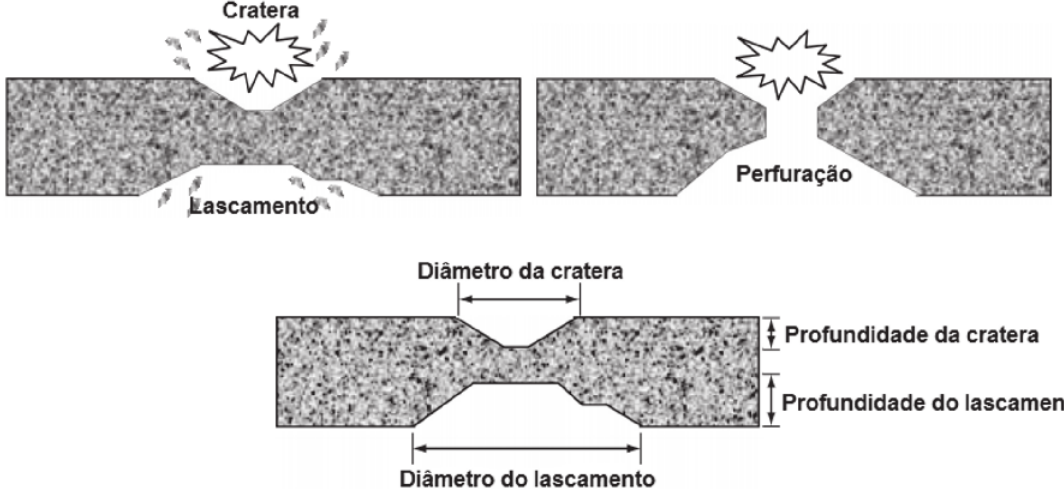
Padrão de dano e dimensões importantes para explosões por contato, Beppu et al.